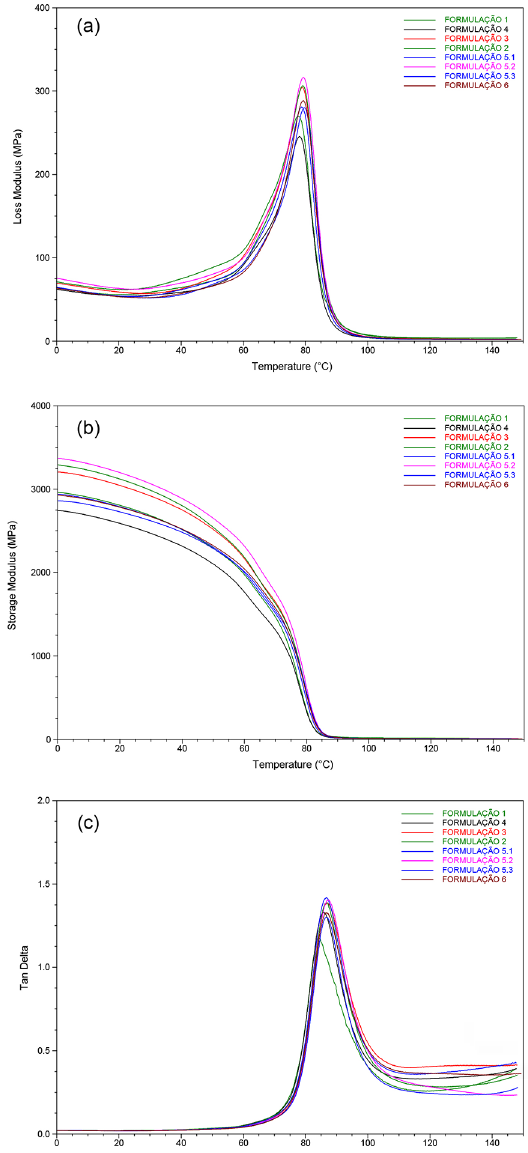
Figure 10. DMA curves for PVC formulations: (a) E’’xT and (b) E’xT (c) Tan delta.